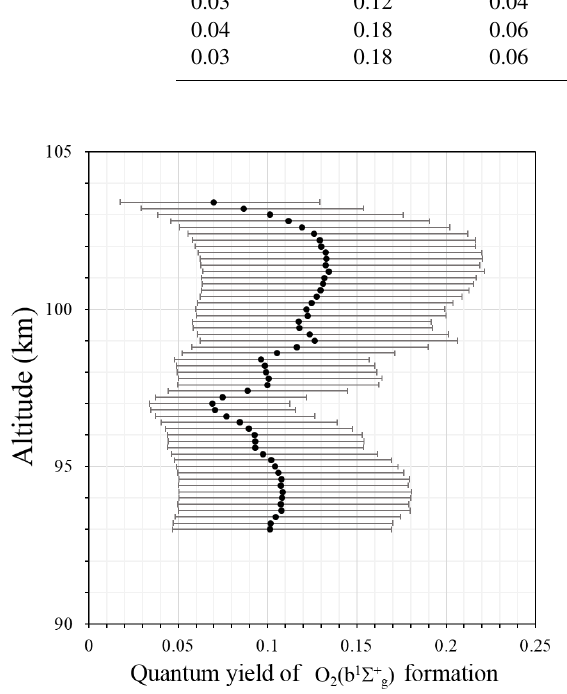
Figure 2. Quantum yield of O 2 (b 1 (cid:54) + g ) formation ε for the case of the one-step mechanism.